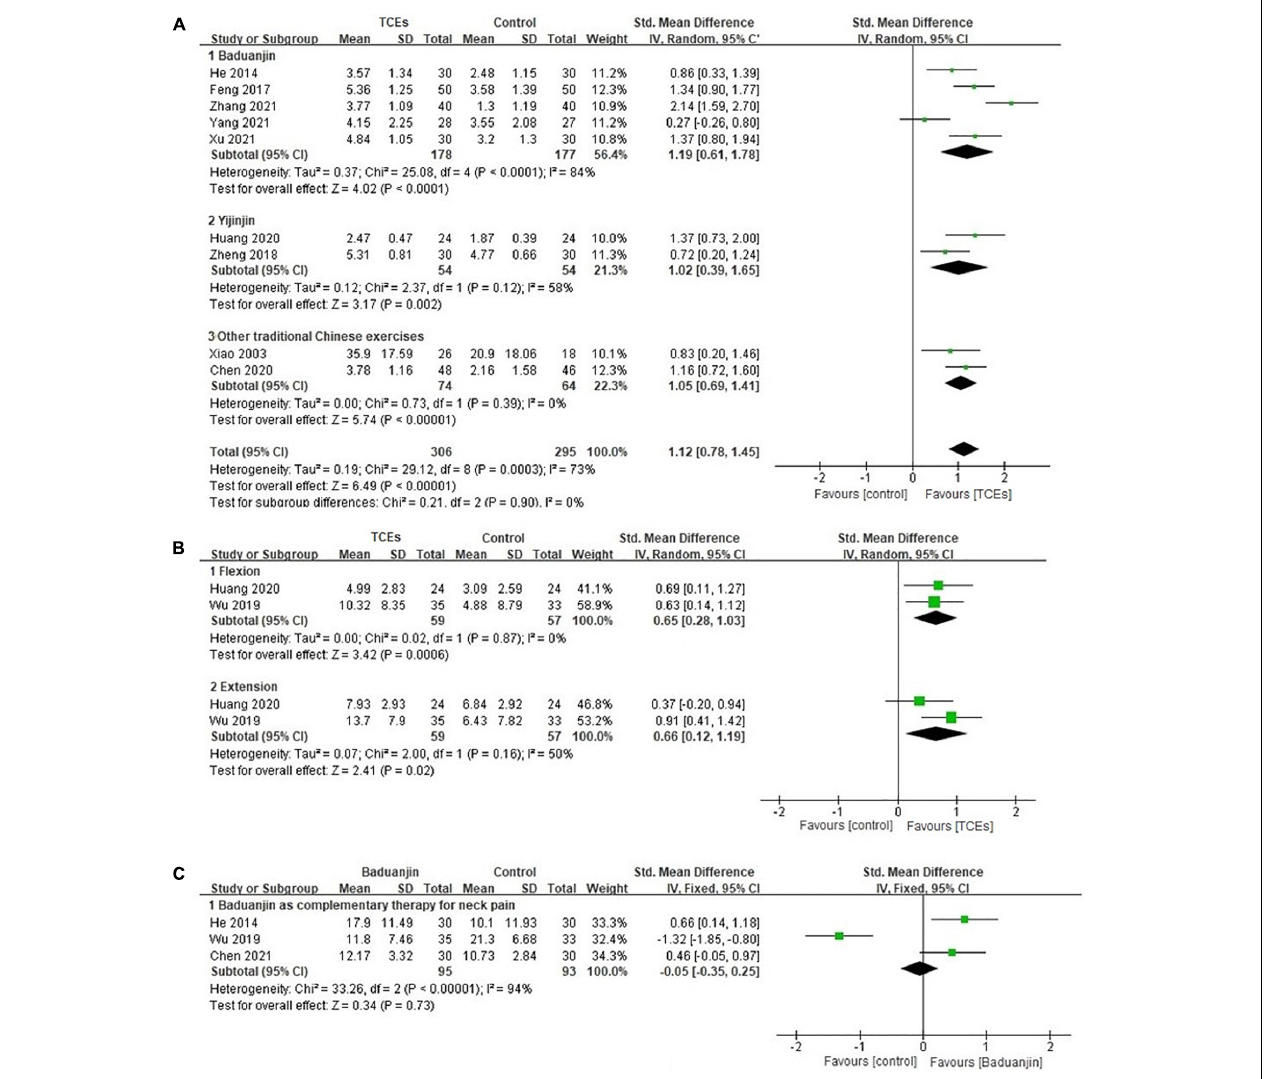
FIGURE 2 | Forest plot of the complementary effects of traditional Chinese exercises (TCEs) for neck pain: (A) Pain, (B) range of motion, and (C)